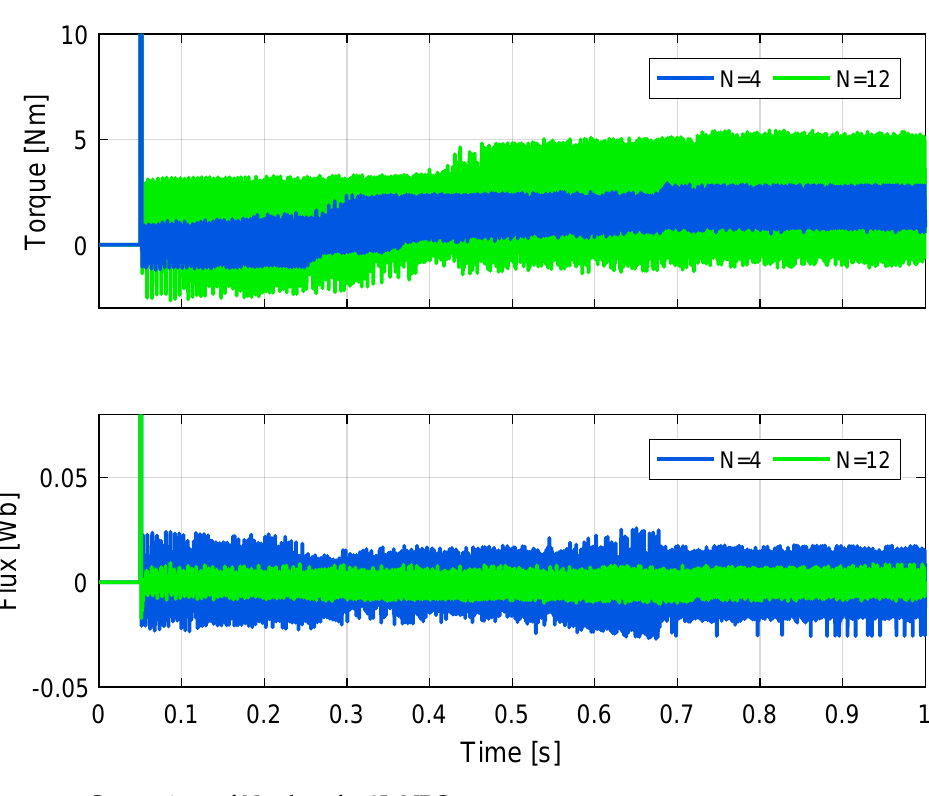
Figure 15. Comparison of N values for 3L-NPC.